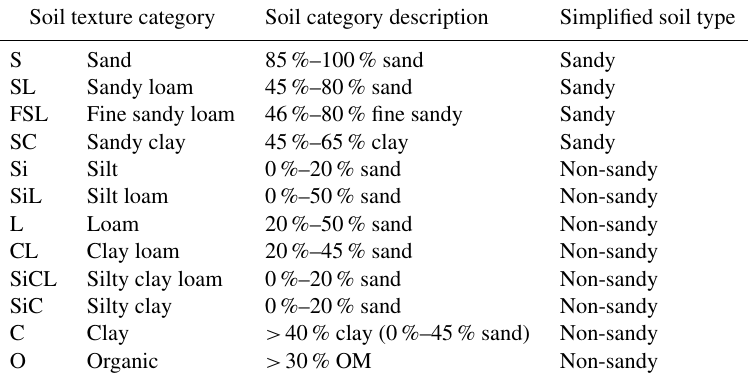
Table 2. Soil texture categories (British Columbia protocol for estimating soil texture in the field (https://www.for.gov.bc.ca/isb/forms/lib/ fs238.pdf)) and simplified soil